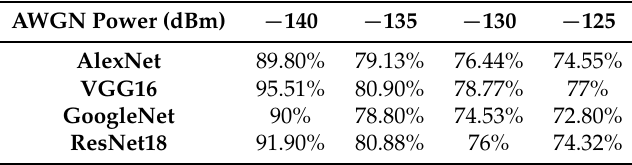
Table 2. Prediction results of the trained CNNs for RFI classification at different noise powers.